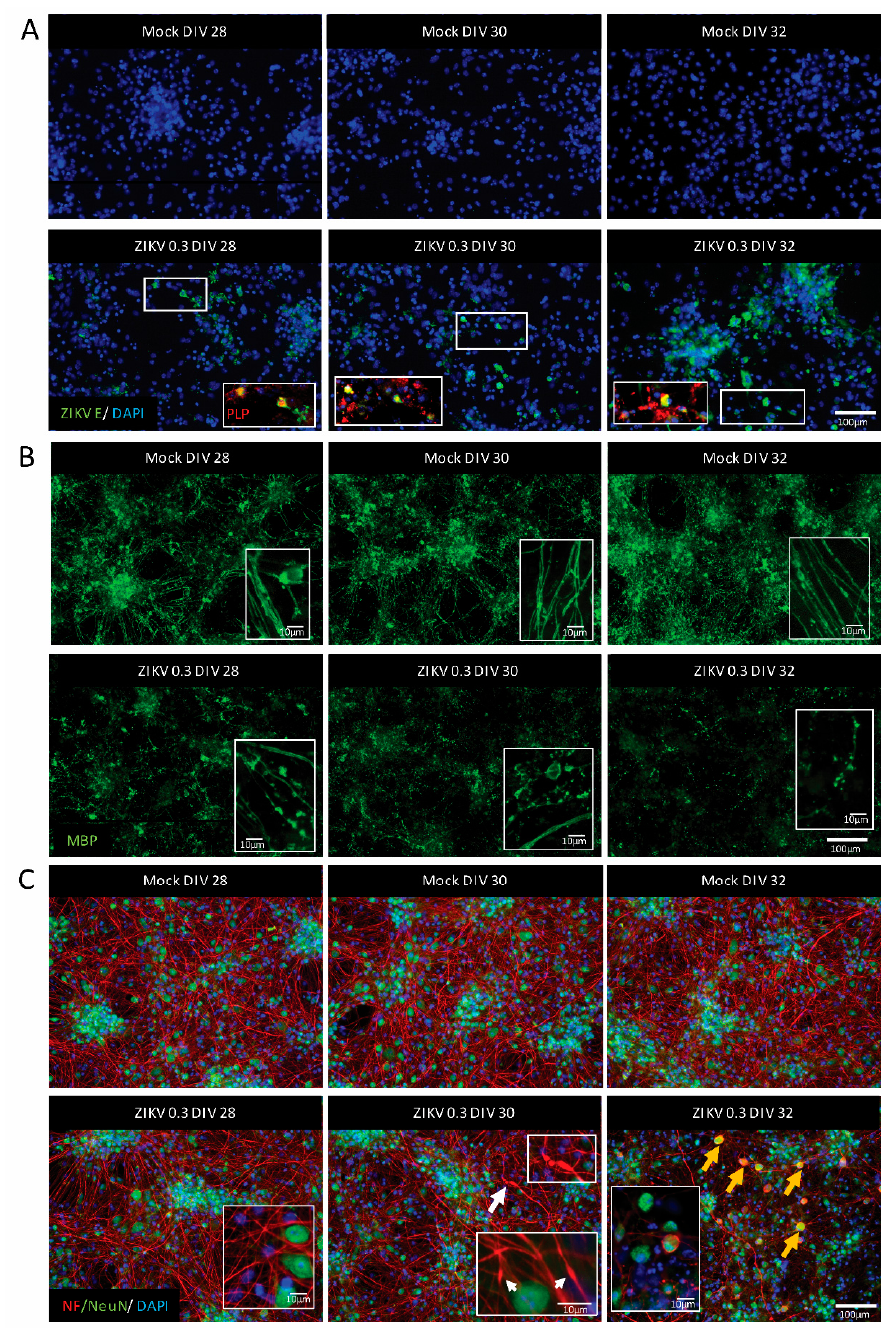
Figure 3. ZIKV infection of mature CNS cultures was accompanied by myelin damage and axonal injury. Representative images of mature mouse CNS cultures infected with ZIKV on DIV 26 with MOI 0.3 ( n = 3). Images taken at 2 dpi (DIV 28), 4 dpi (DIV 30), and 6 dpi (DIV 32). Upper panels show mock-infected and lower panels show ZIKV-infected samples. ( A ) ZIKV-infected cells (ZIKV E staining, green signal), and oligodendrocyte staining as determined by co-labeling with PLP (red signal). Insets are enlarged areas of the presented image. White rectangles show the origin of the enlarged area. Scale bar = 100 µ m. ( B ) Myelin sheaths visualized by MBP staining (green signal). Scale bar = 100 µ m. Insets show high magnification images of myelin; scale bars = 10 µ m. ( C ) Axonal damage was observed at 4 dpi (the white arrow highlights the damaged axon enlarged in the white rectangle); axonal density visualized by neurofilament (NF) staining (red signal). Neuronal cell bodies (NeuN staining, green signal) showing signs of injury by accumulating neurofilament (yellow arrows). Scale bar = 100 µ m. Insets in images of ZIKV-infected cultures show high-magnification images of axons and neuronal cell bodies with white arrows indicating axonal injury; scale bar = 10 µ